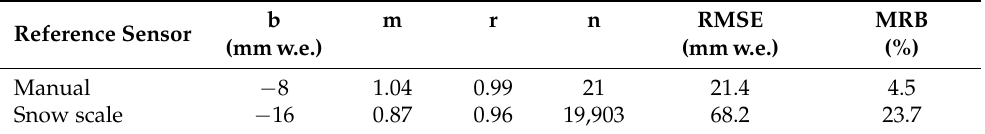
Table 3. Regression coefficients for the comparison of the GNSS-derived SWE with the manual (weekly) and snow scale (10min) observations for 2021/22; b and m are the offset and slope of the linear regression fit, and n is the number of samples.